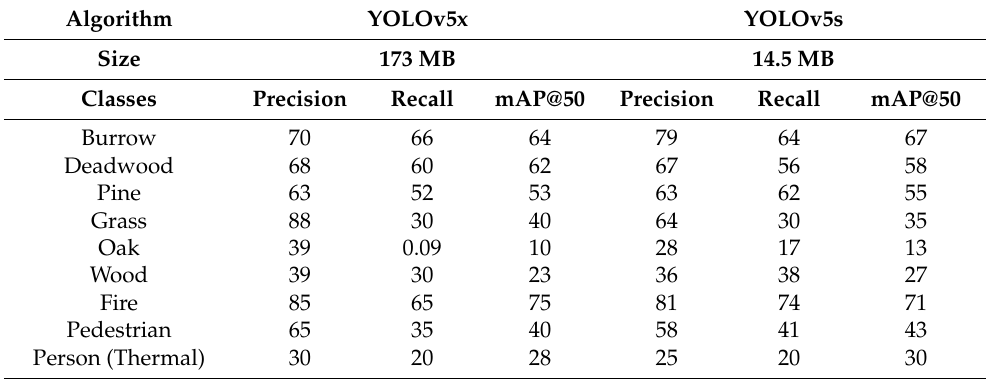
Table 2. Results of comparing YOLOv5x and YOLOv5s models for FHI, Fire and Person